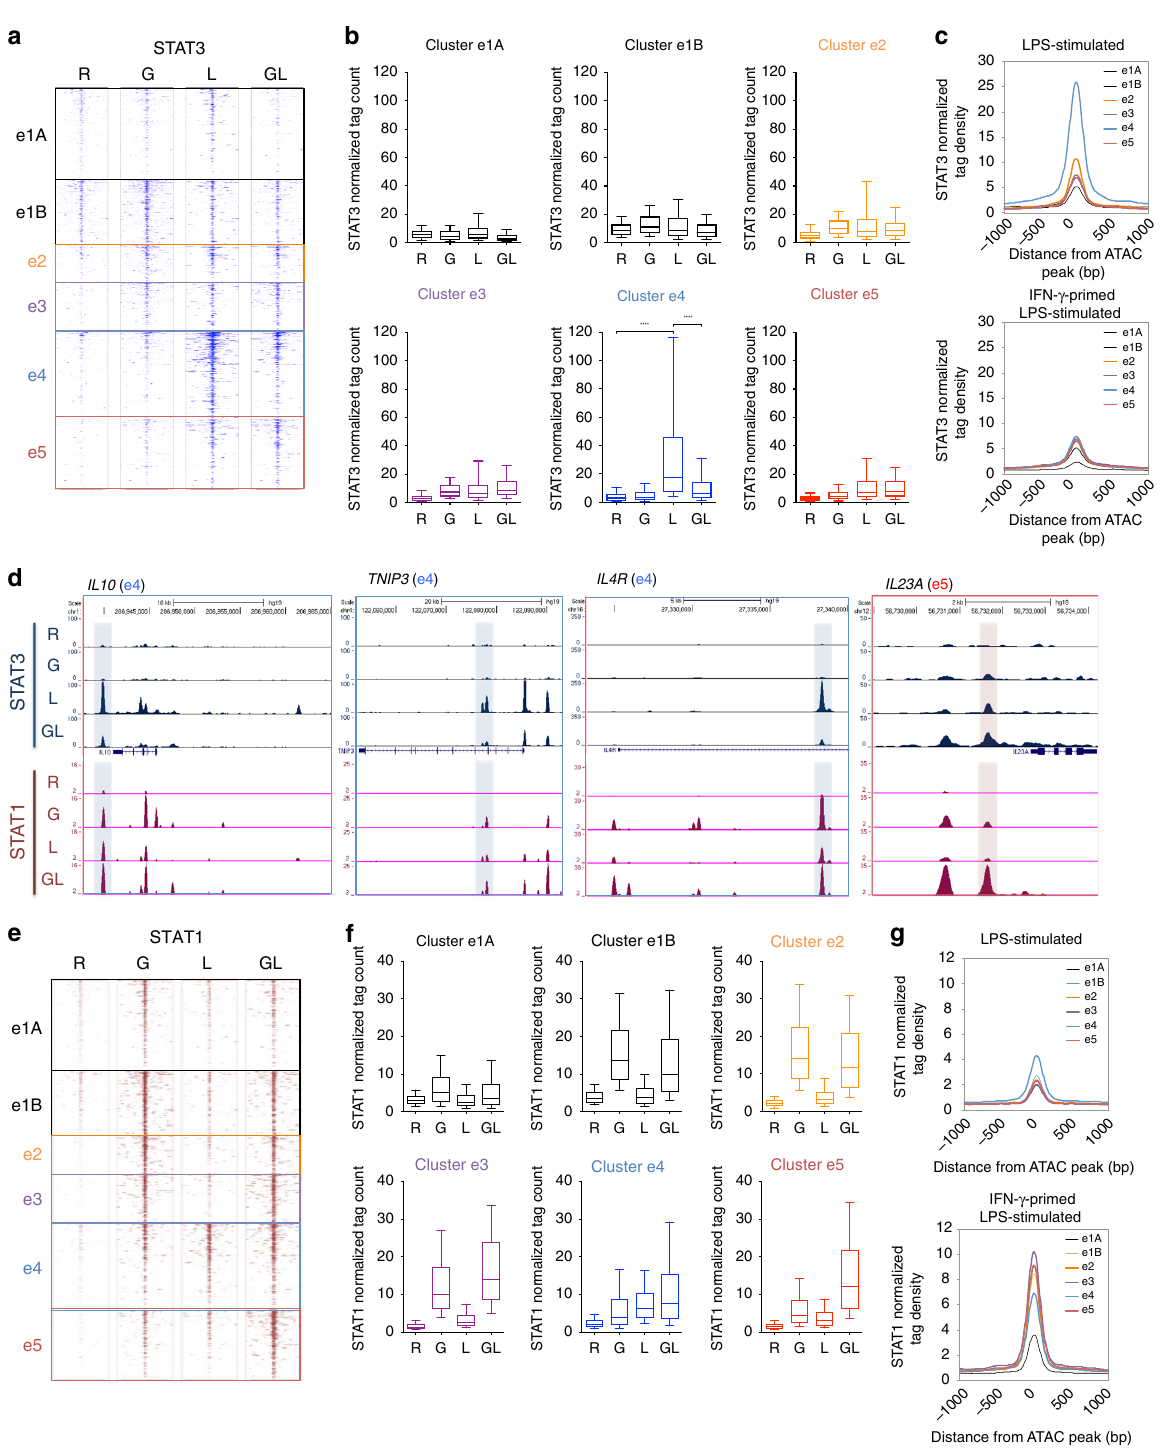
Fig. 4 Differential occupancy of STAT3 and STAT1 at e4 and e5 enhancers. a Heatmaps showing STAT3 ChIP-seq signals at each enhancer cluster de fi ned in Fig. 2a. b Boxplots depicting normalized tag counts at each enhancer cluster. **** p < 0.0001, paired-samples Wilcoxon signed-rank test. c Distribution of the average signal of STAT3 ChIP-seq at each enhancer cluster in LPS-stimulated (top) and IFN- γ -primed LPS-stimulated macrophages (bottom). d Representative UCSC Genome Browser tracks displaying normalized tag-density pro fi les at enhancers of IL10, TNIP3, IL4R , and IL23A in the four indicated conditions. Boxes enclose cluster e4 enhancer (blue) and cluster e5 enhancer (red). e Heatmaps showing STAT1 ChIP-seq signals at each enhancer cluster. f The boxplots indicate normalized tag counts at each enhancer cluster. g Distribution of the average signal of STAT1 ChIP-seq at each enhancer cluster in LPS-stimulated (top) and IFN- γ -primed LPS-stimulated macrophages (bottom). Data are representative of two independent experiments each of which included at least two independent donors ( a – d ) or are from GSE43036 ( e – g ). Boxes encompass the twenty- fi fth to seventy- fi fth percentile changes. Whiskers extend to the tenth and ninetieth percentiles. The central horizontal bar indicates the median